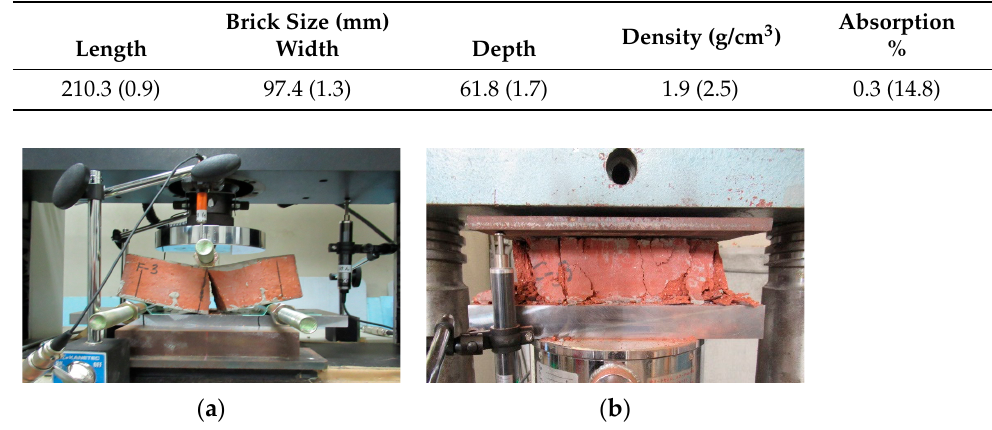
Figure 1. Failures of brick tests. ( a ) Flexural test; ( b ) Compression test.